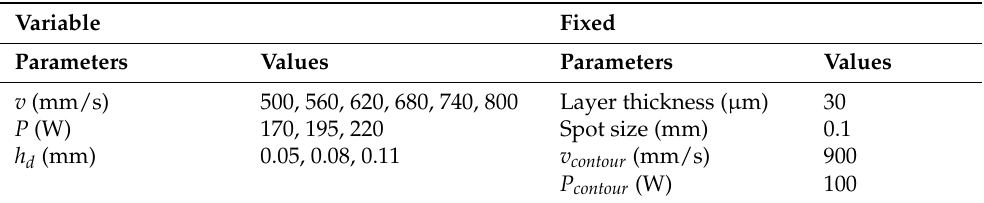
Table 2. Variable and fixed process parameters employed. Variable